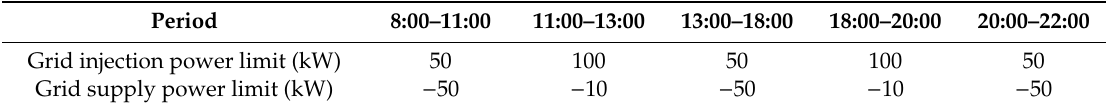
Table 2. Power limits of the public grid.